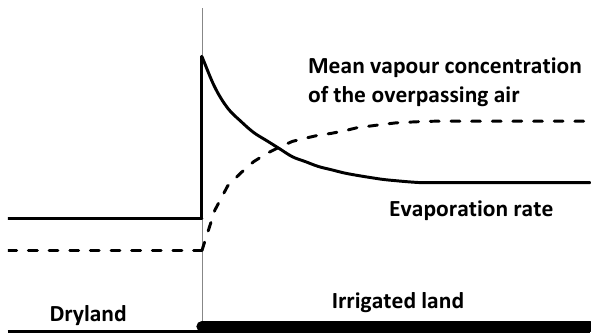
Fig. 1. Conceptual representation of the effect of advected air pass- ing from dryland over an irrigated